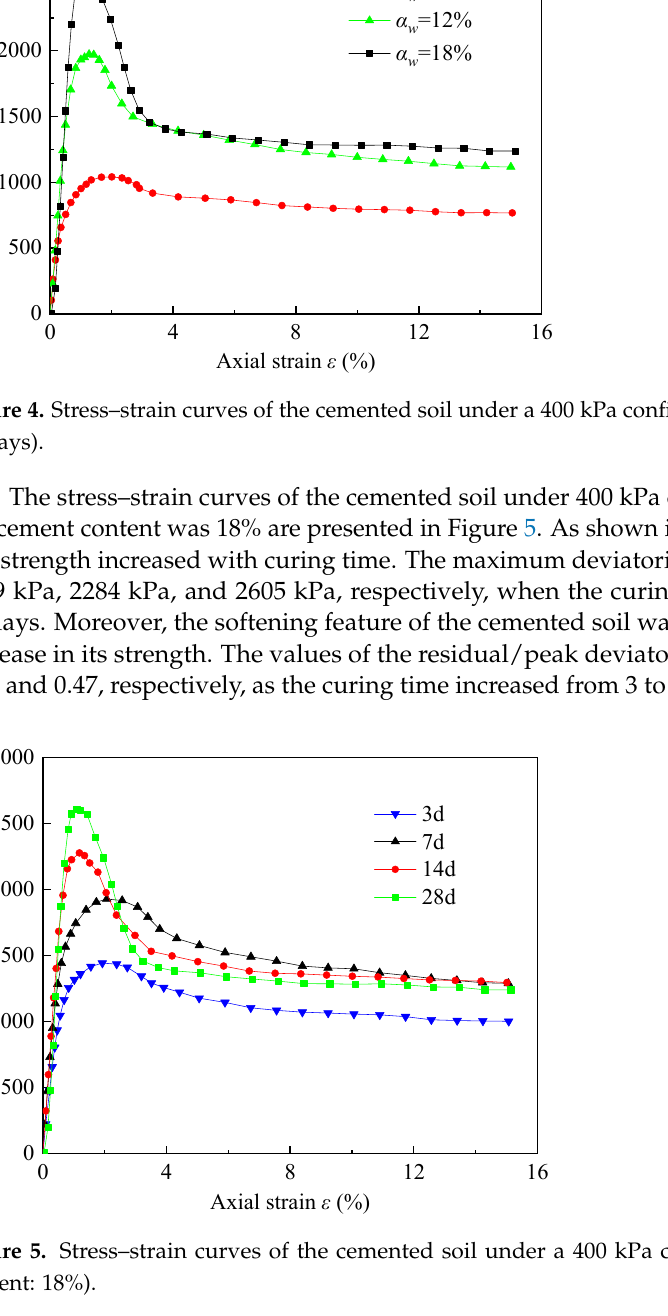
Figure 6. Variation in the brittleness index with confining pressure (curing time: 28 days). According to Figure 6, the brittleness index decreased rapidly with the confining pressure when the confining pressure increased from 100 kPa to 400 kPa. For the cemented soil with 18% cement content, the brittleness index decreased from 0.664 to 0.529 as the confining pressure increased to 400 kPa from 100 kPa. It can also be seen in Figure 6 that the brittleness index almost remained stable as the confining pressure grew to 1600 kPa from 400 kPa. For the cemented soil with 18% cement content, the brittleness index was